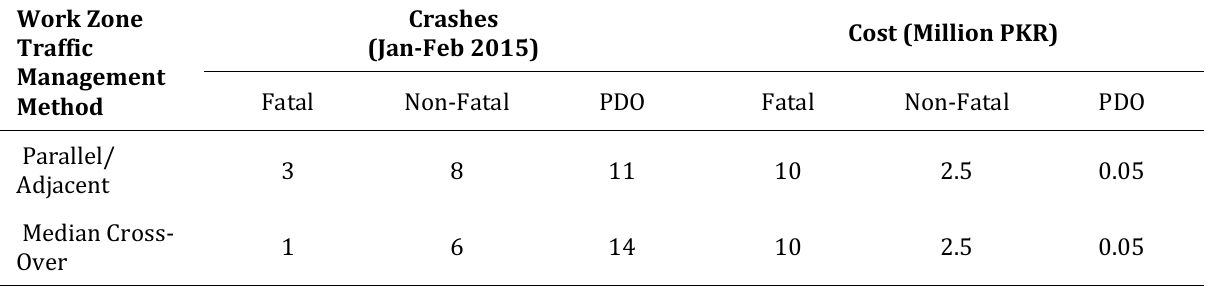
Table 6. Crash Cost Saving (Safety